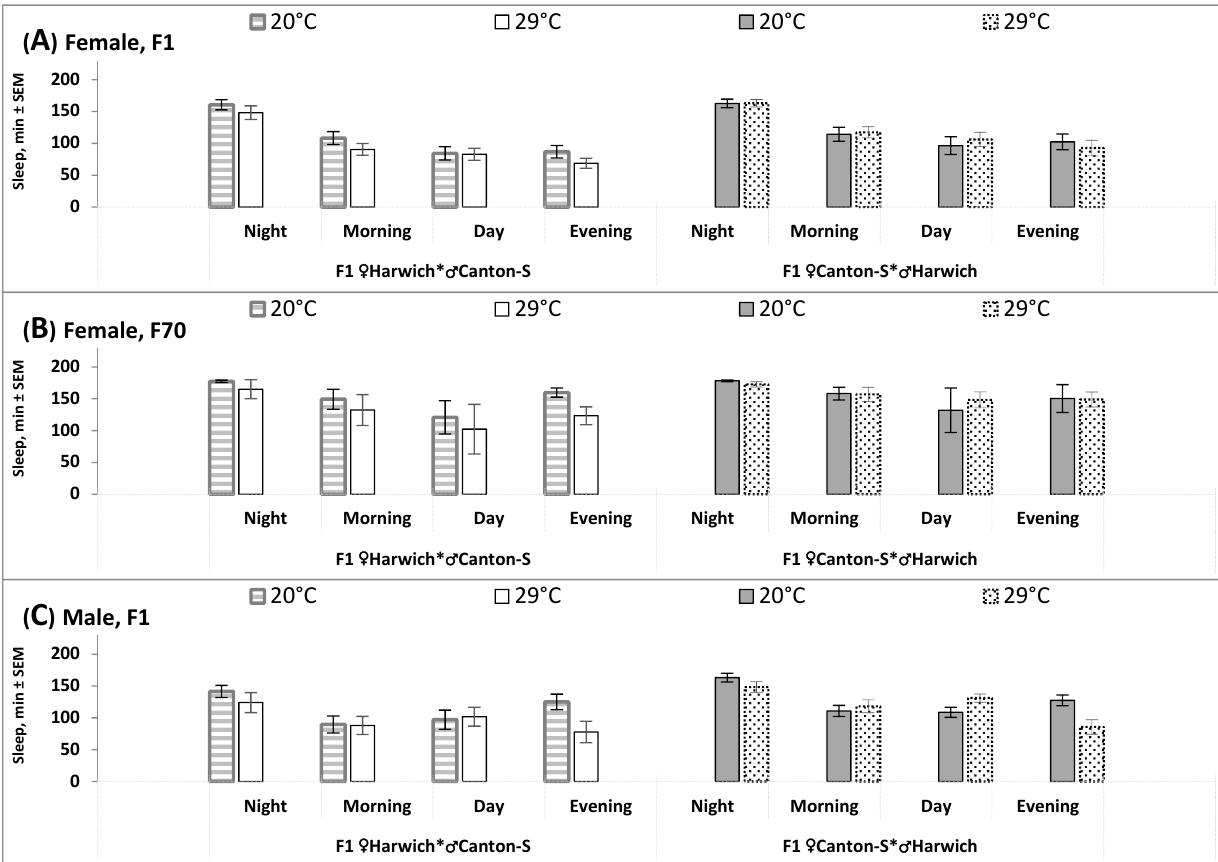
Figure 3. Sleep in four 6-h time intervals of the 24-h cycle in intra-specific hybrids of two cross directions. After averaging sleep over 30-min intervals (Figure 2), it was summed as four 6-h time intervals to compare the amounts of sleep during Night (between 22:00 and 4:00), Morning (between 4:00 and 10:00), Day (between 10:00 and 16:00), and Evening (between 16:00 and 22:00); 20 ◦ C and 29 ◦ C: Two air temperatures; ( A – C ) The 1st and 70th generations of female hybrids, respectively (Females, F1 and F70), and the 1st generation of female hybrids (Males, F1). H C-S: Crosses from females of Harwich ♀ ♂ strain and males of Canton-S strain; C-S H: The reciprocal crosses (Canton-S females and Harwich males), females are ♀ ♂ sterile under high developmental temperature ( A , right) and fertile under normal developmental temperature ( B , right); SEM: Standard Error of Mean. See the results of t-tests and sample sizes for each plot in Table